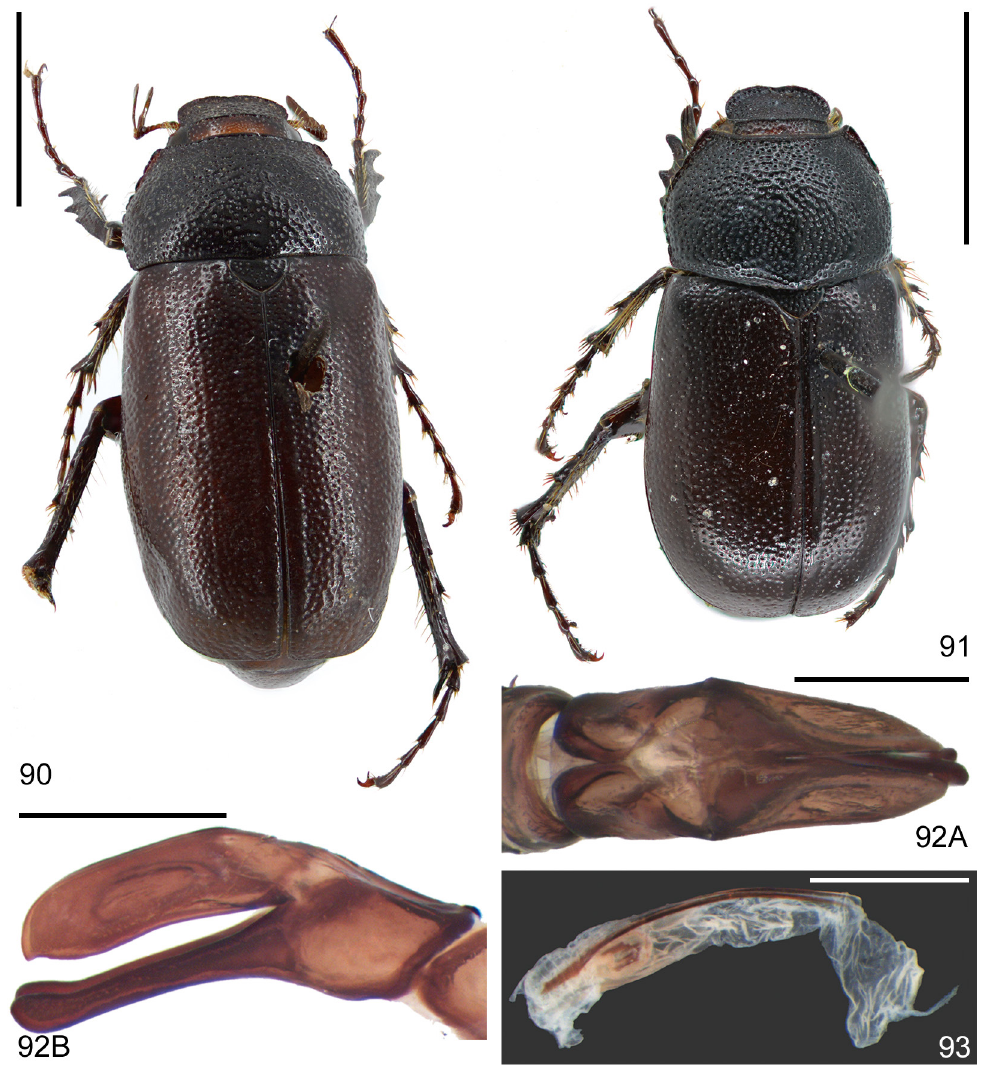
Figs 90–93. 90 . Miridiba rugaticollis (Moser, 1913), lectotype, ♂ (MFNB). Habitus in dorsal view. 91–93 . M. nigrescens (Moser, 1916), lectotype, ♂ (MFNB). 91 . Habitus in dorsal view. 92 . Parameres in dorsal (A) and lateral (B) views. 93 . Endophallus and temones in lateral view. Scale bars: 90–91 = 5.0 mm; 92–93 = 1.0